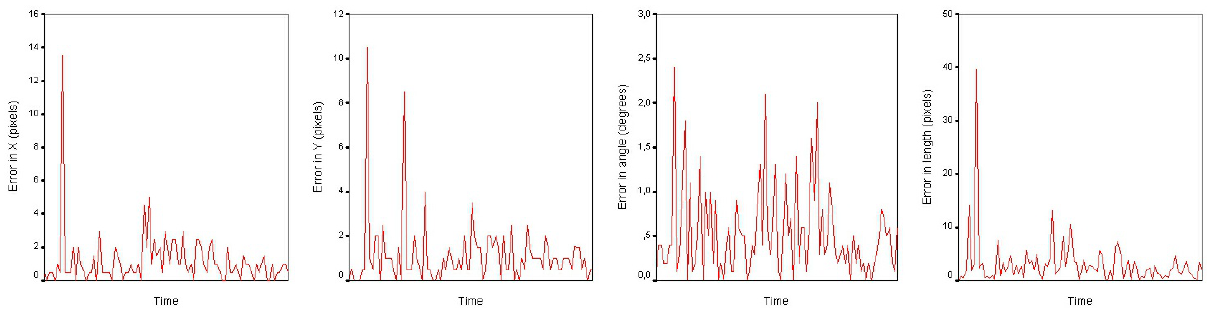
Figure 8. Tracking error during a recorded sequence in position in X and Y orientation and